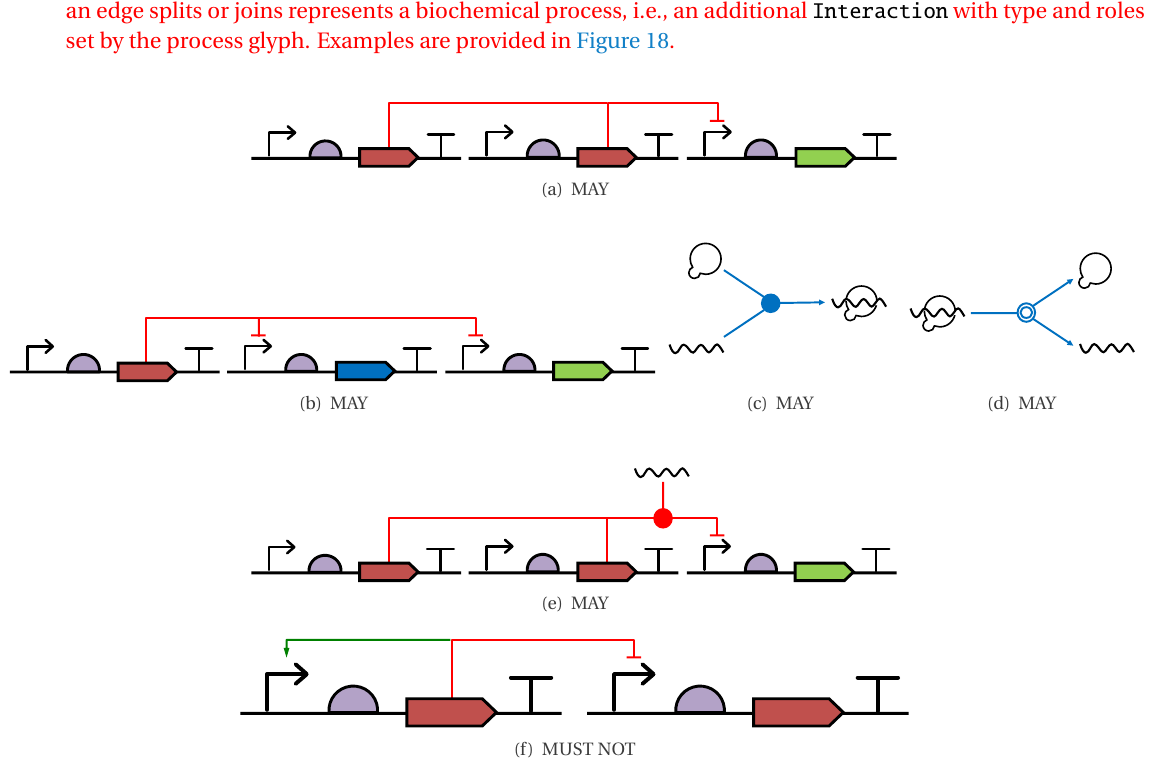
Figure 18: Examples of use of multi-head and multi-tail arrows: (a) Repression from multiple independent sources, (b) repressor with multiple targets, (c) association of gRNA and Cas9 into an active CRISPR complex and (d) the dissociation of that complex, and (e) composite edges representing two interactions: CRISPR complex formation with Cas9 from two sources, which then represses a promoter. (f) Multi-head interactions, however, MUST NOT use different glyphs for different